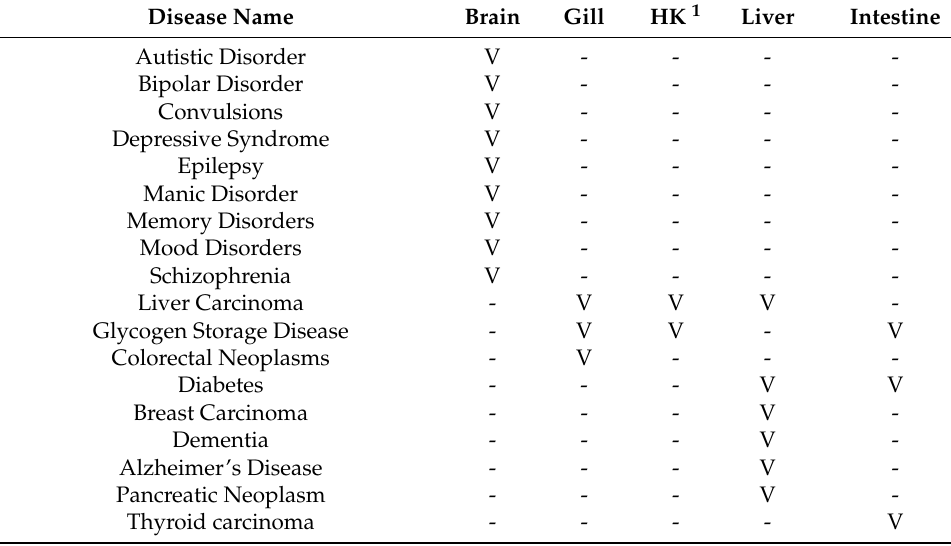
Table 7. Human diseases related to KEGG analysis in common